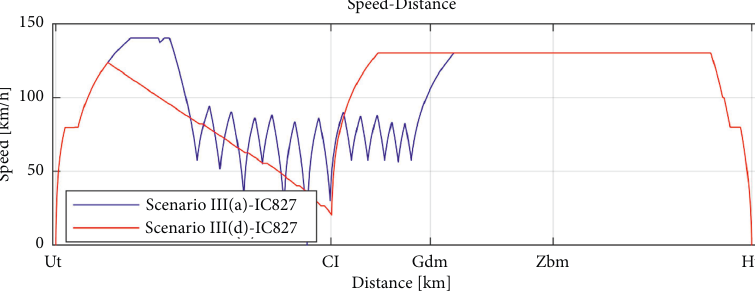
Figure 12: Speed profiles of IC827 for Scenarios III (a) and III